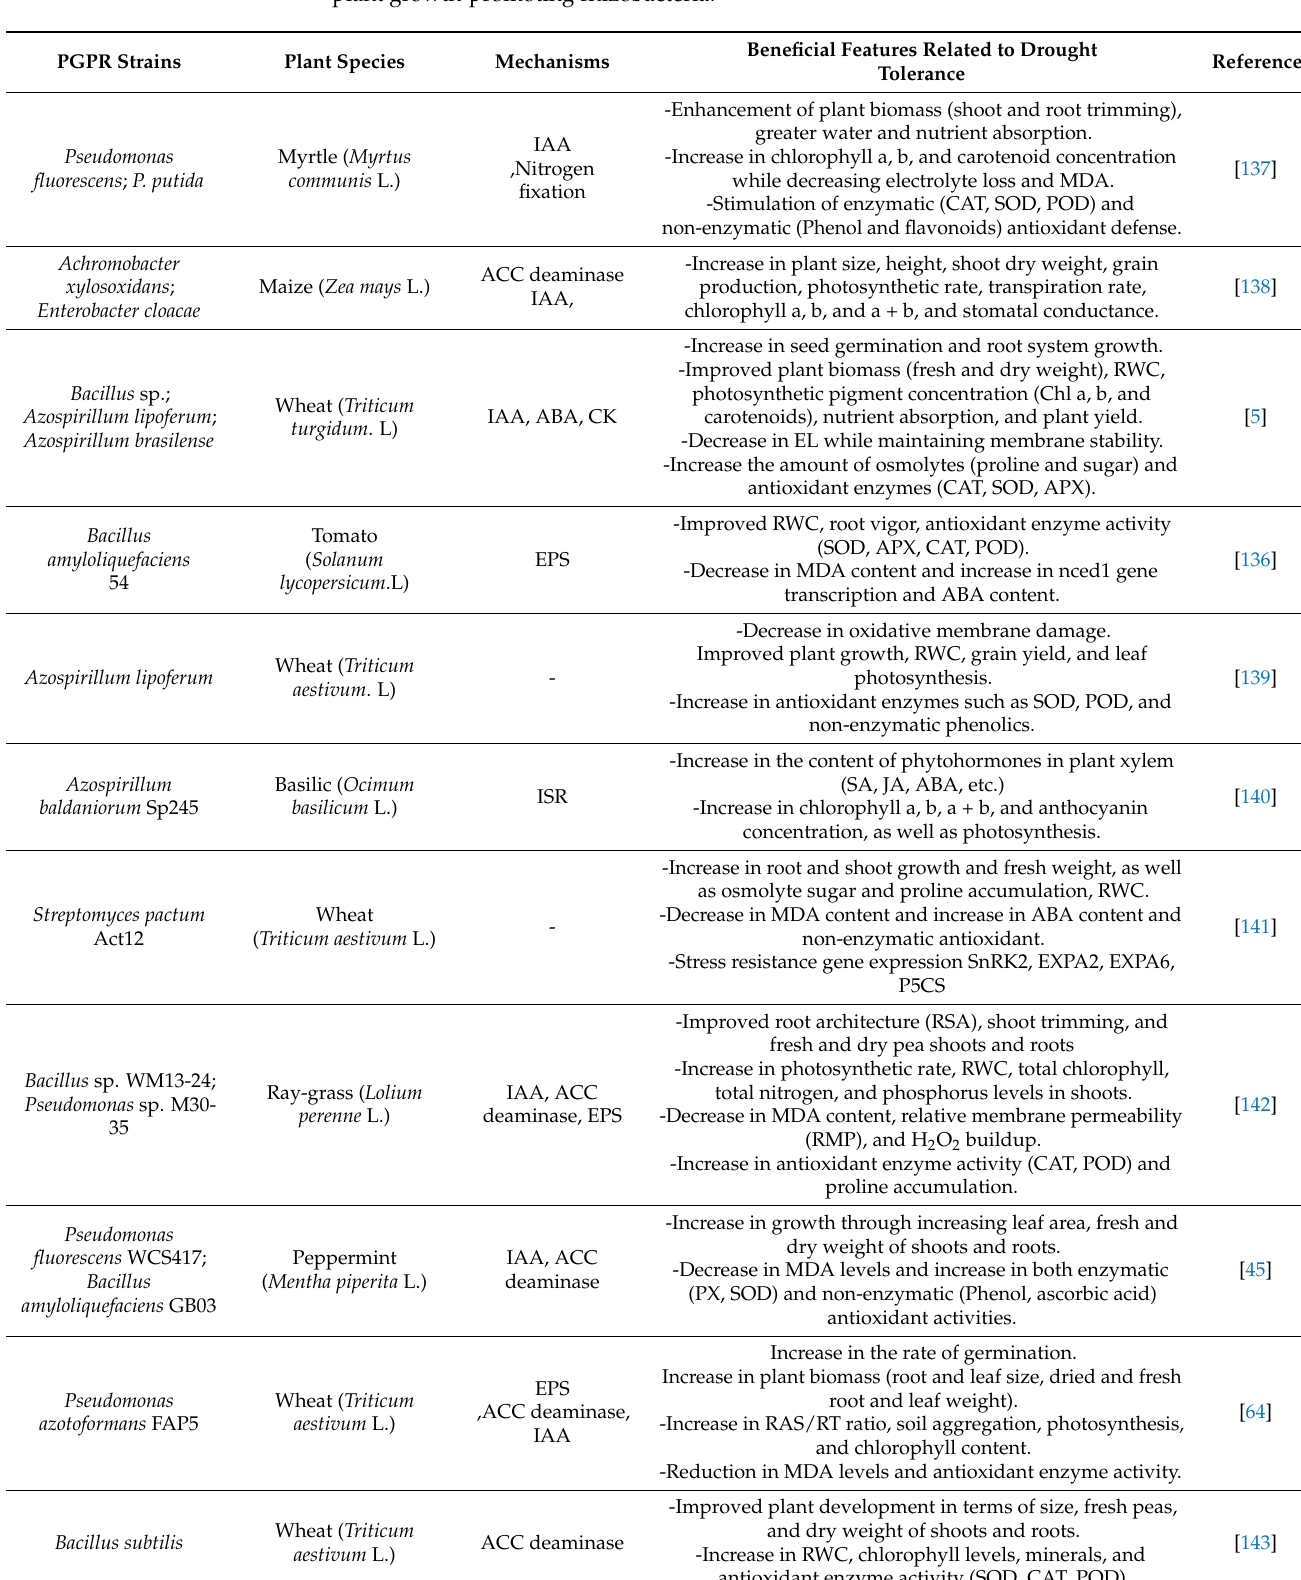
Table 2. Alleviation of drought stress in several crops through the application of new and diversified plant growth-promoting